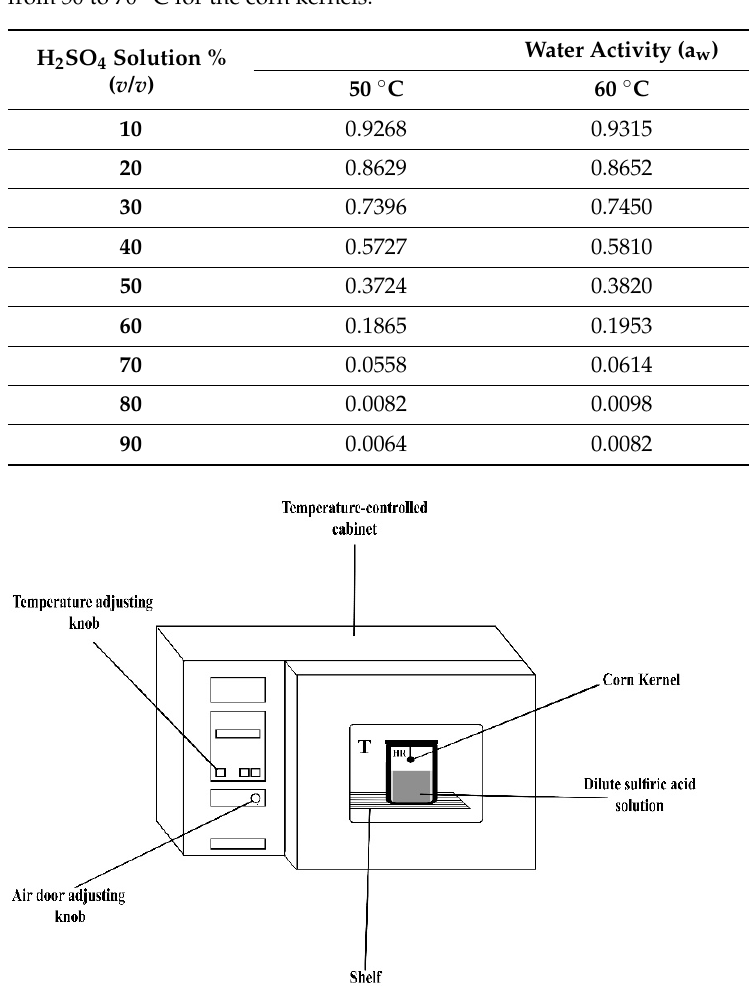
Figure 4. Schematic diagram of the experimental device.